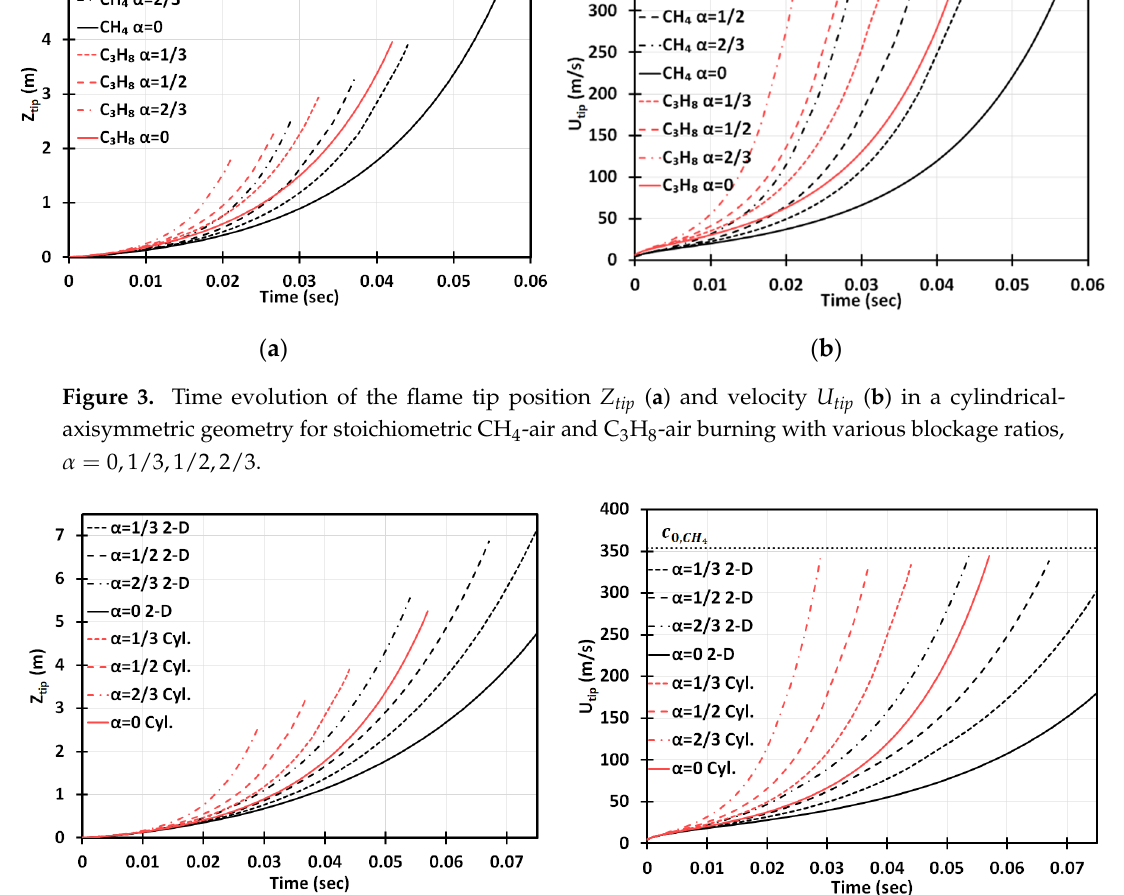
Figure 3. Time evolution of the flame tip position (cid:1852) (cid:3047)(cid:3036)(cid:3043) ( a ) and velocity (cid:1847) (cid:3047)(cid:3036)(cid:3043) ( b ) in a cylindrical- axisymmetric geometry for stoichiometric CH 4 -air and C 3 H 8 -air burning with various blockage ratios, (cid:2009) = 0, 1 3,⁄ 1 2,⁄ 2 3⁄ .